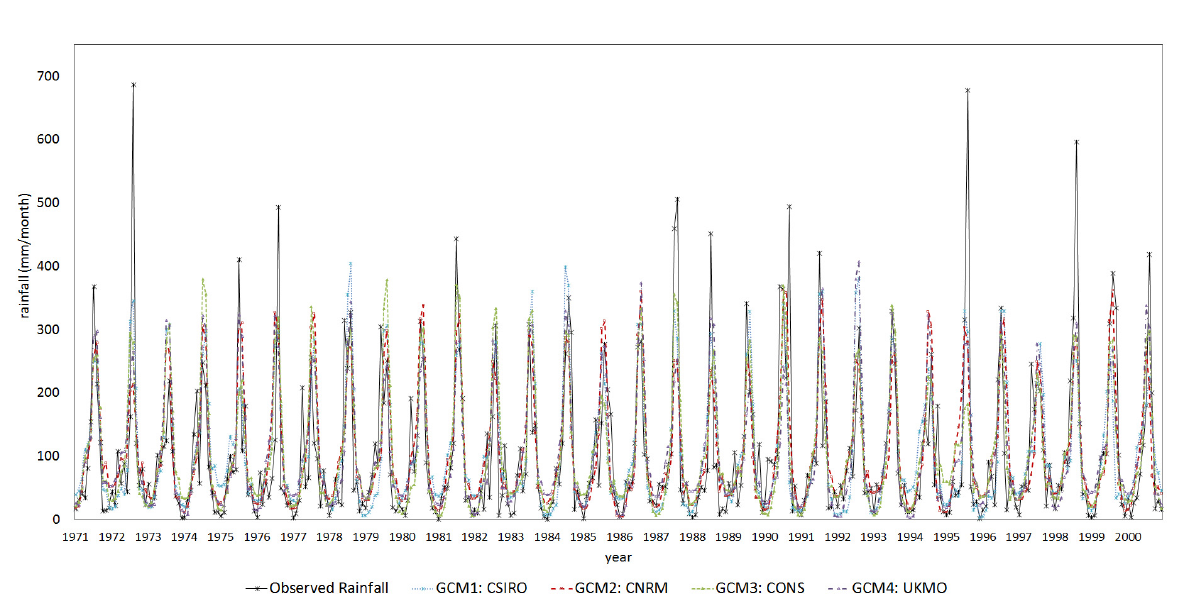
Figure 1. Time series plots of the observed and simulated monthly rainfall of four GCMs under the A2 scenario for the Korean